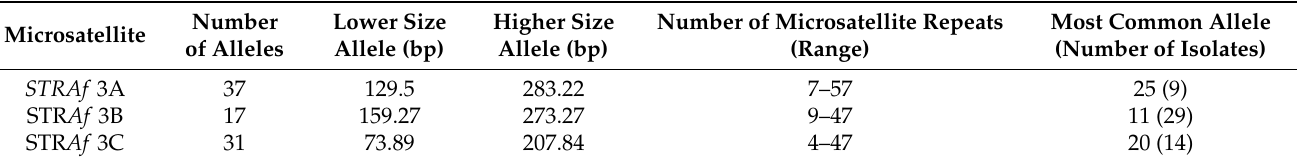
Table 3. Characterization of the alleles obtained in the microsatellite genotyping study of 100 viable Aspergillus fumigatus sensu stricto